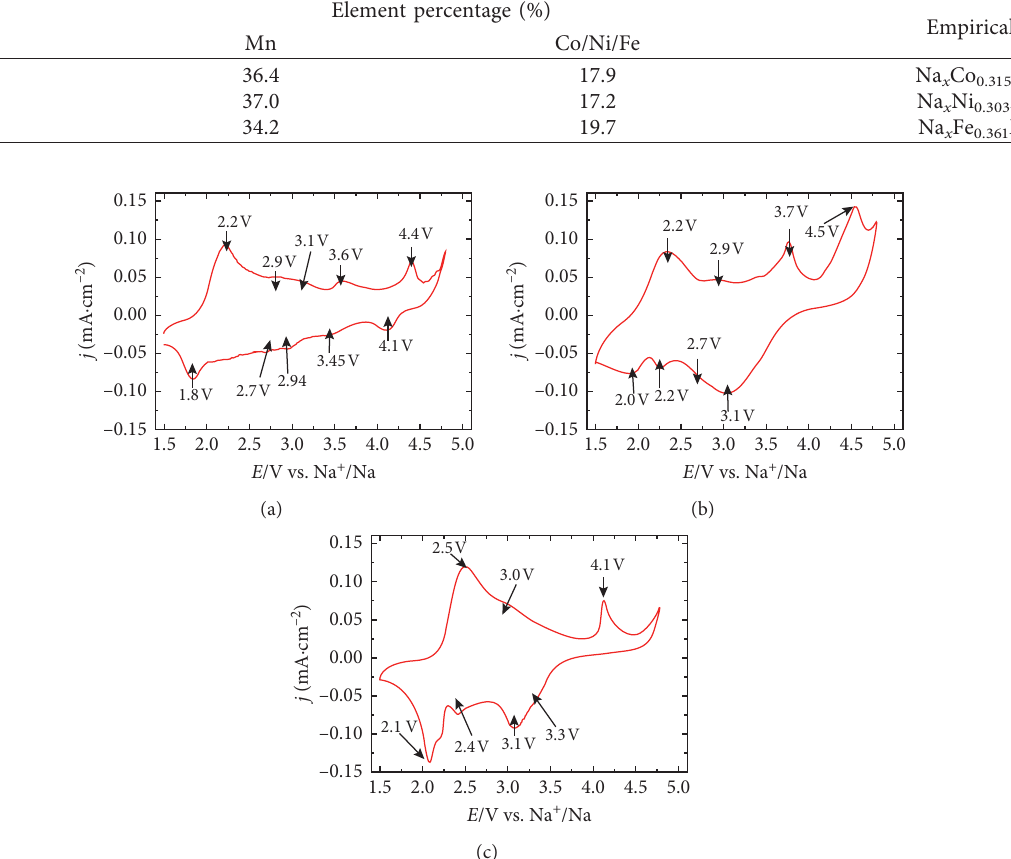
Figure 2: Cyclic voltammogram of the as-prepared samples in the voltage range of 1.5–4.8V at 50 μ V · s − 1 . (a) NaCMO, (b) NaNMO, and (c) NaFMO.